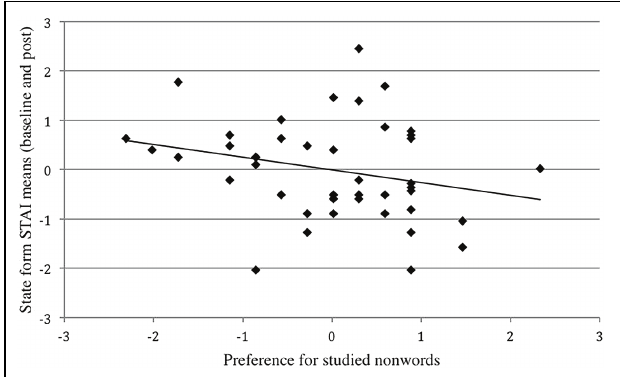
FIGURE 2 | Scatterplot of standardized-scores for the state form of the STAI with preference for studied nonwords, Study 2. Greater state anxiety correlated with reduced preference for studied nonwords, r = − 0.26, p =